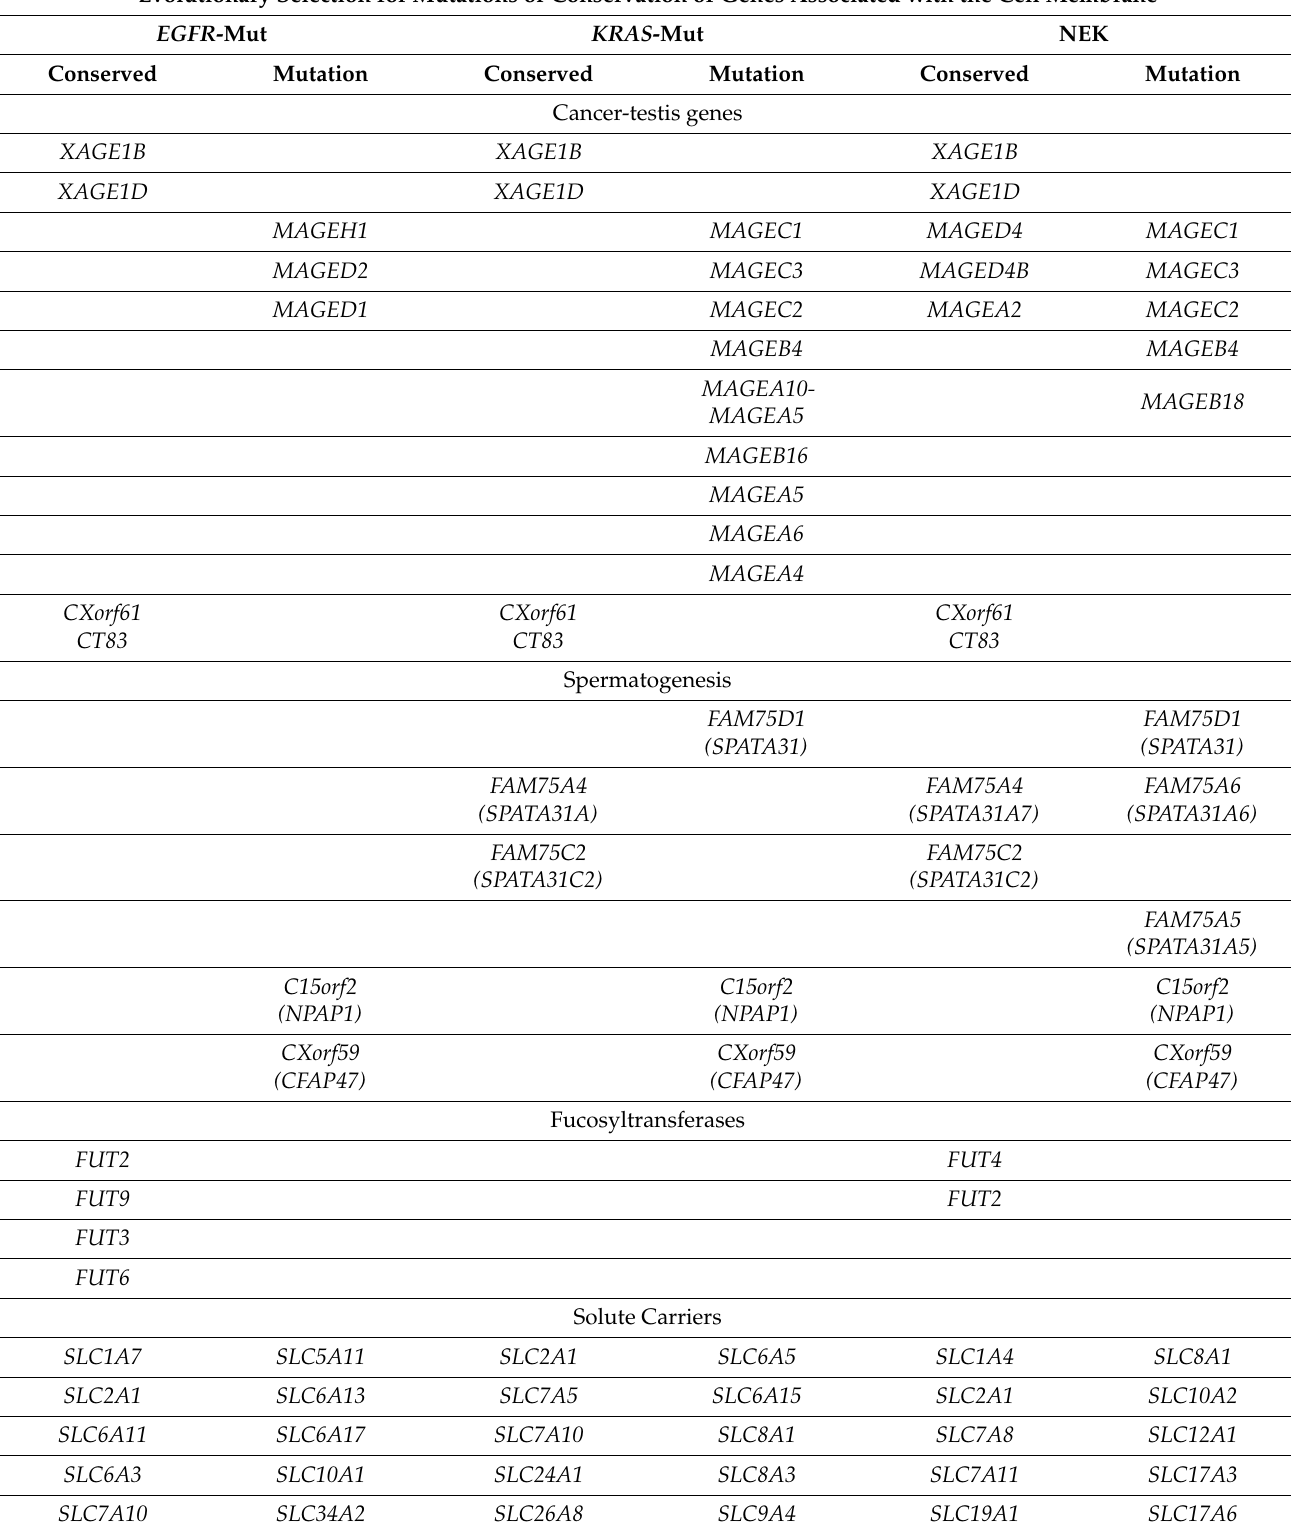
Table 4. Cont. Evolutionary Selection for Mutations or Conservation of Genes Associated with the Cell